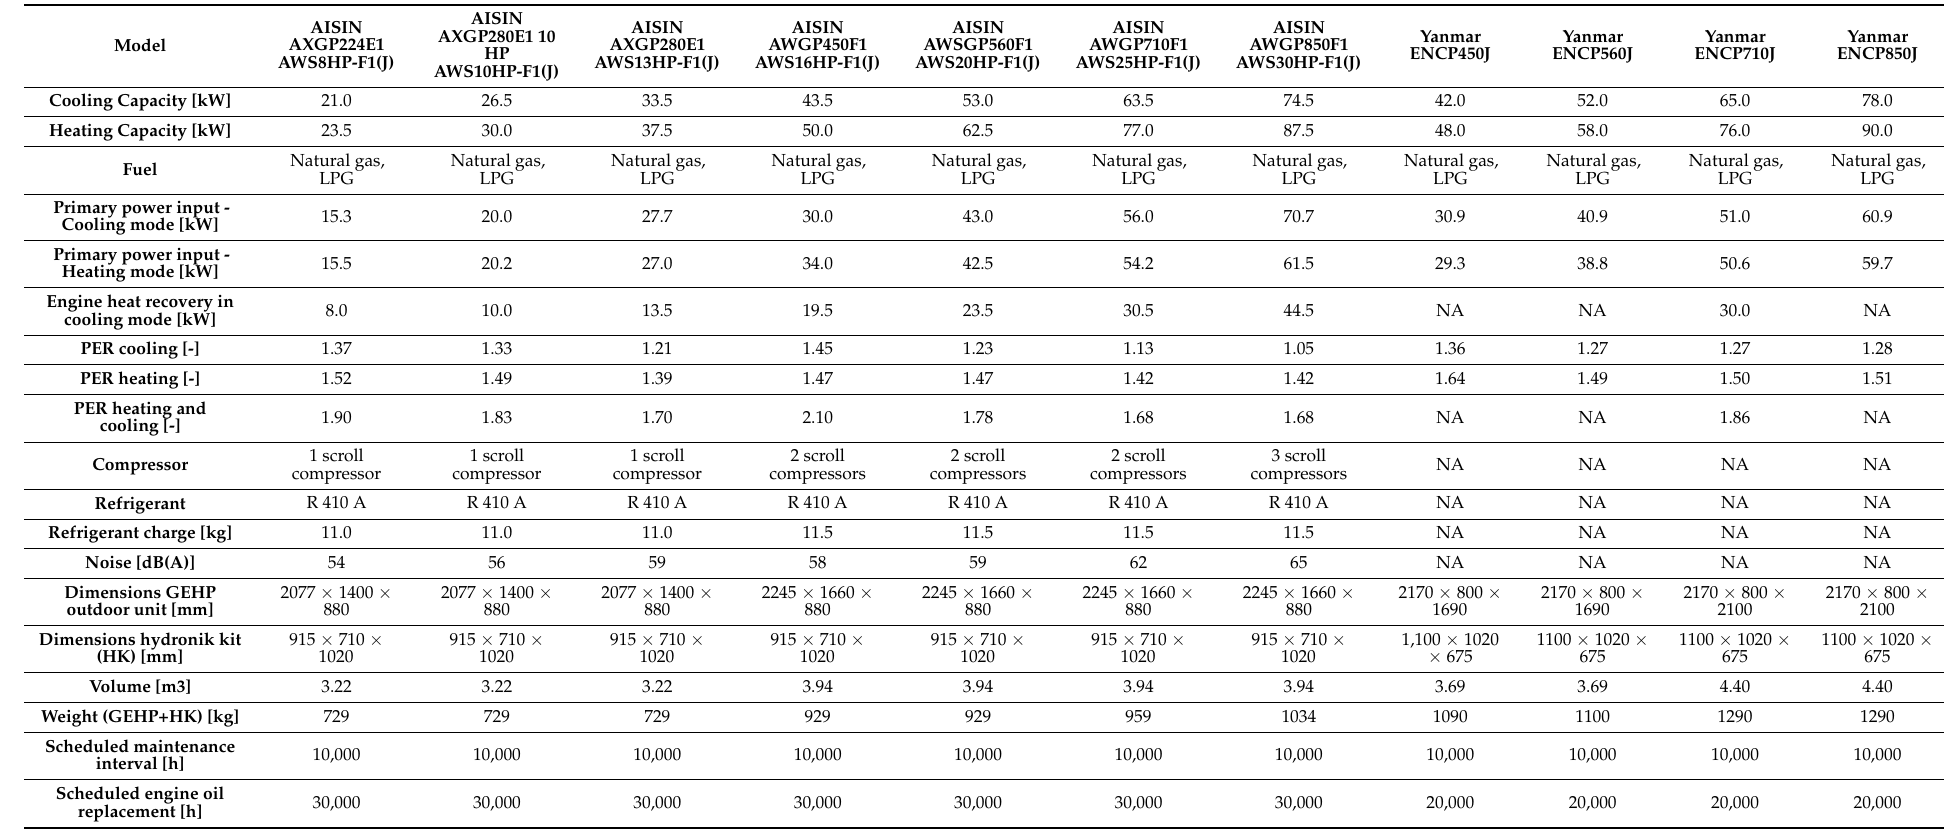
Table A3. Air-to-water GEHPs (cooling: A35/W7, heating: A7/W45) available on the European